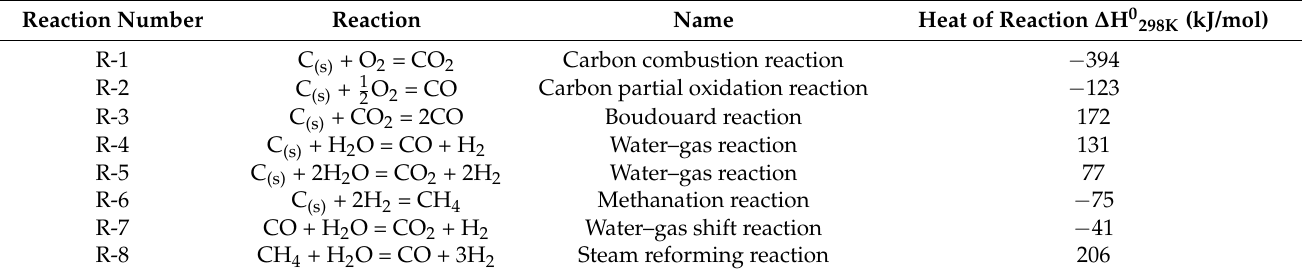
Table 1. Chemical reactions involved in the gasification process [13,30,31]. Reaction